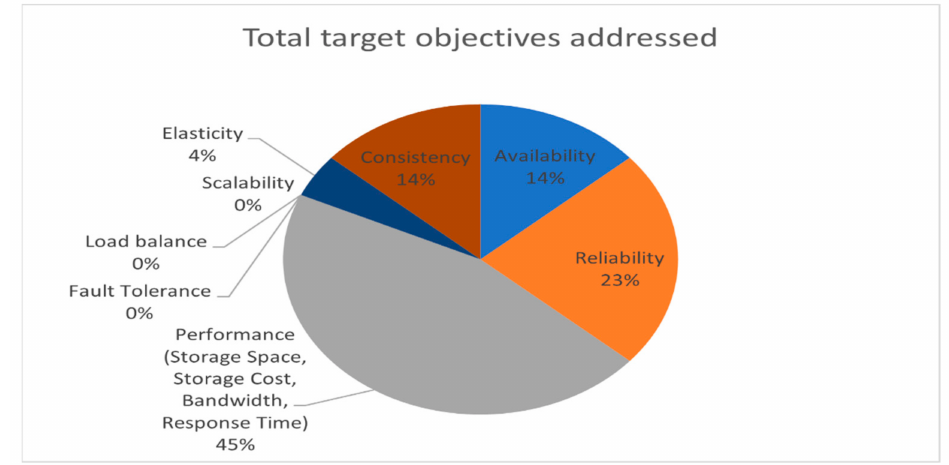
Figure 6. Pie chart of target objectives addressed directly in target-oriented replication